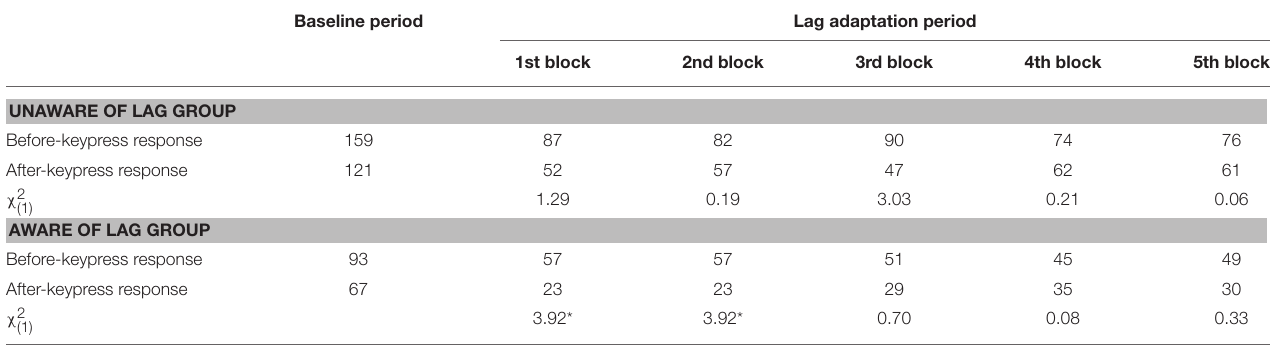
TABLE 2 | Results of TOJ task in Experiment 2.